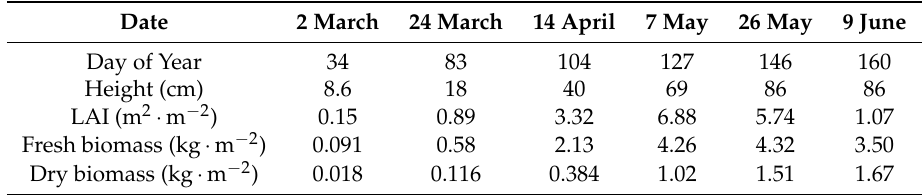
Table 1. Height, leaf area index (LAI), and aerial biomass of the crop at different dates during the measurement